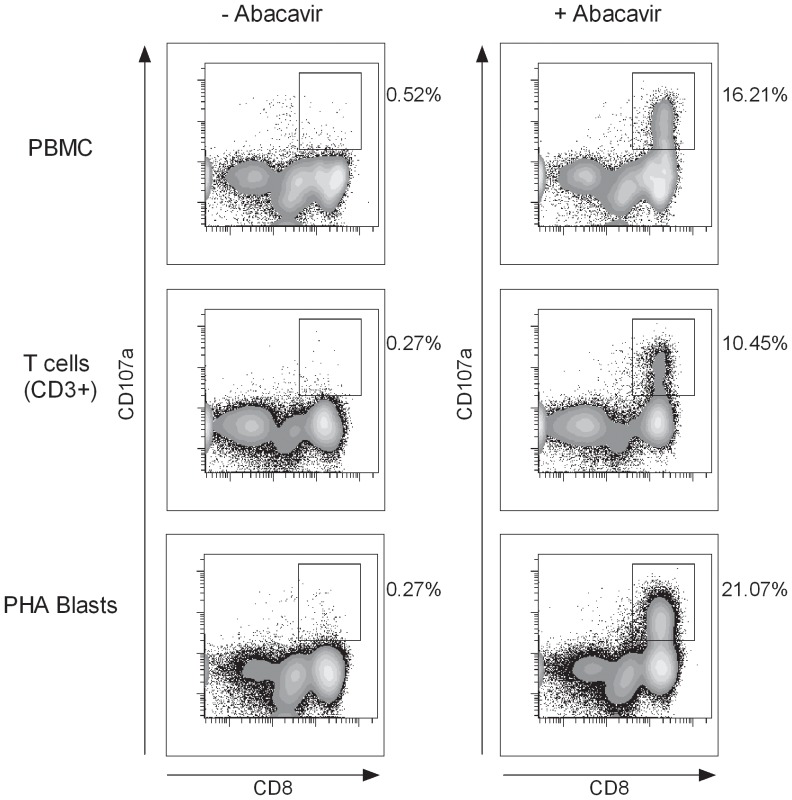
Abacavir-reacting T cells can be induced in vitro in the absence of APC.PBMC, CD3+ sorted T cells, and 14 days old PHA-blast from ID-453 were cultured in the presence of abacavir (10 µg/ml). Drug reactivity was monitored on day 14 in a degranulation (CD107a) assay after a six hours drug-specific restimulation assay. Plots are gated on CD3+ T cells and percentages relate to the CD8+ CD107a+ T cell population. Representative data from three independent experiments are shown.